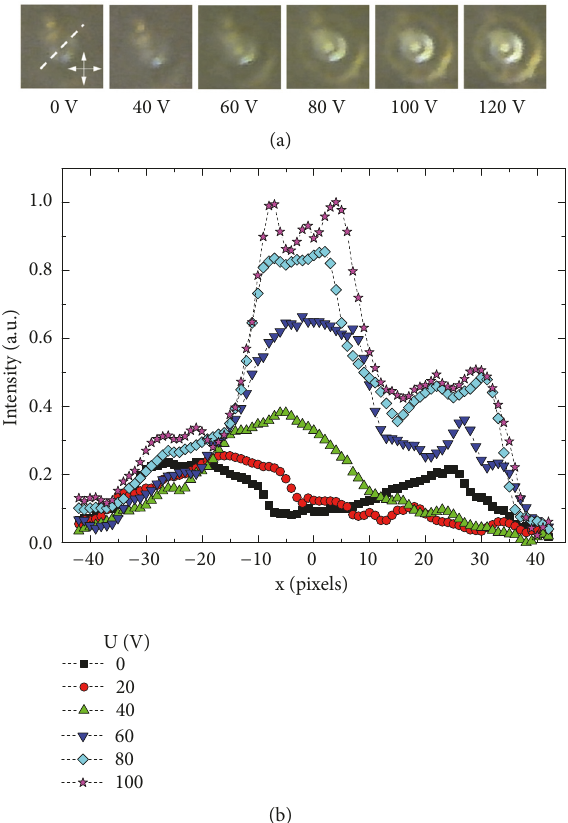
Figure 9: (a) Microscopic images of a single pore of the PET film filled with LC and (b) the intensity profiles measured along the dashed lines for the film rotated by different angles with respect to the polarizers.